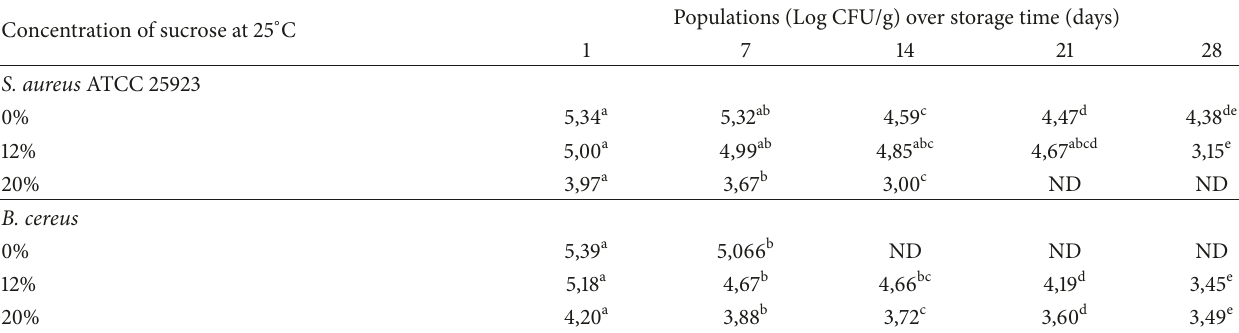
Populations (Log CFU/g) over storage time